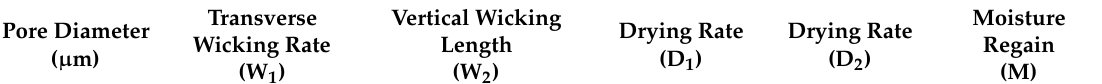
Table 4. Correlation coefficient between each parameter related to the absorption and drying of the